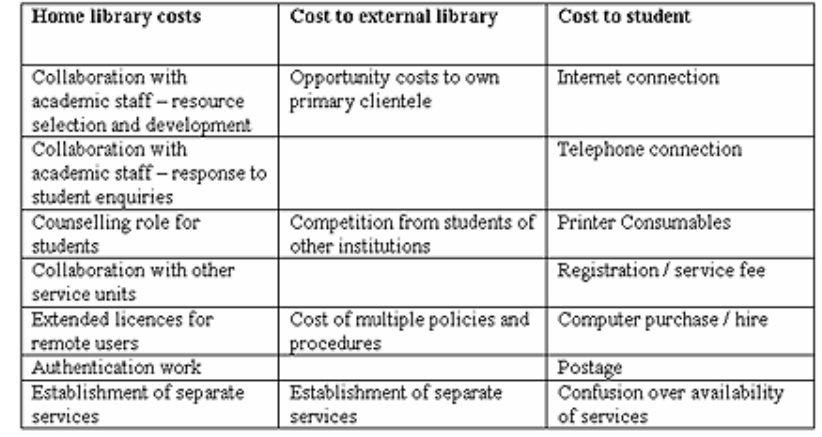
Table 2. The hidden costs of a distance education library